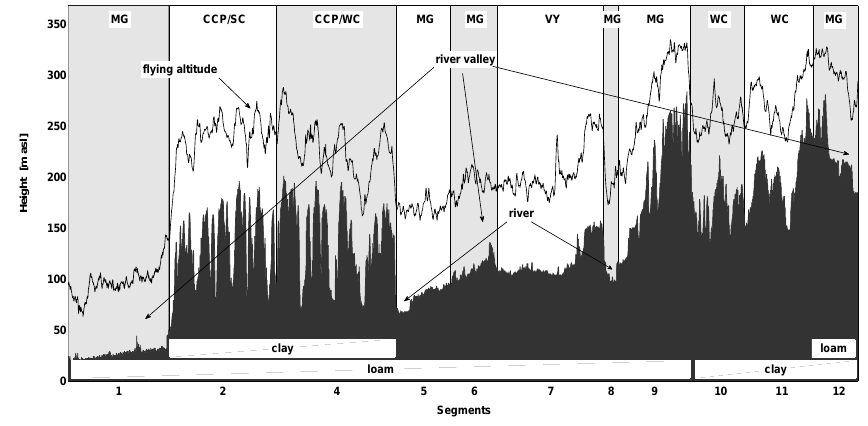
Fig. 3. Terrain elevation along flight track and an example of the flying altitude from a flight between Marmande to Lamasqu´er`e (left to right) at CERES’07, including segments with labels of main land-use classes (2-character labels; see text for abbreviations) and main soil type (bars).